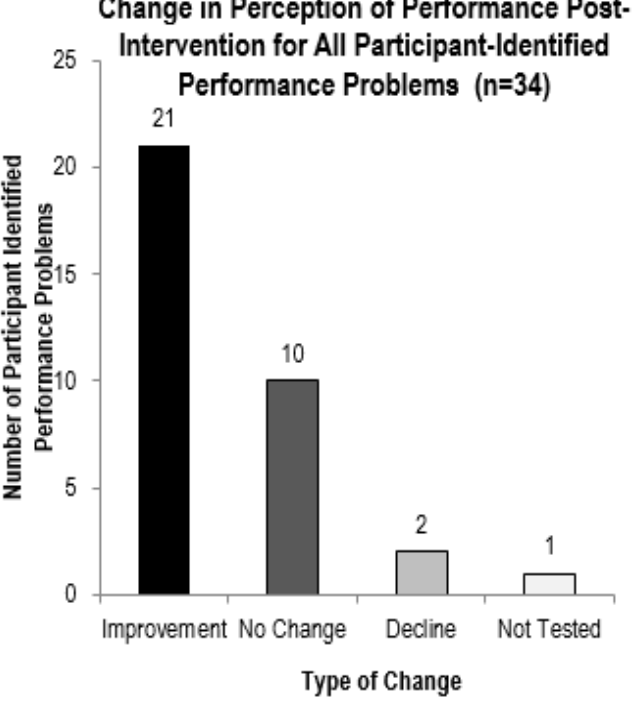
Figure 2. Change in perception of performance post- intervention for all participant-identified problems (n=34) using the COPM.